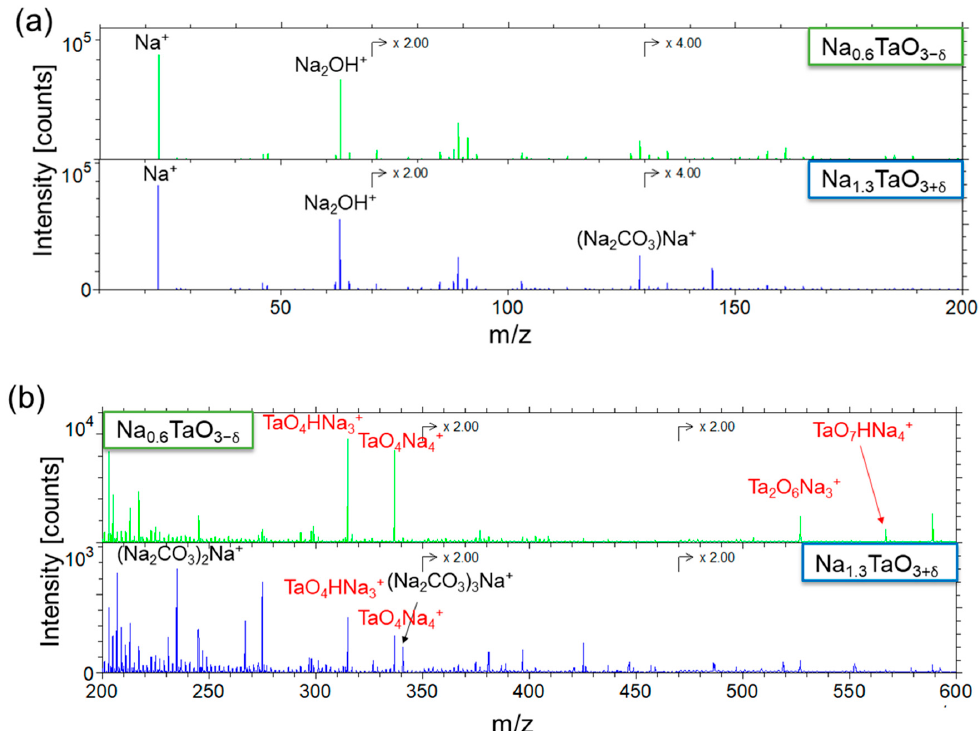
Figure 4. Positive ion ToF-SIMS spectra of Na 0.6 TaO 3- δ and Na 1.3 TaO 3+ δ in the m/z range ( a ) 100–200 and ( b ) 200–600. Both samples were obtained from batch 1_1 (positions 4B and 6C(1), respectively). Only signals ascribed to Na 1+x TaO 3 ± δ and Na 2 CO 3 are reported. The secondary ions characteristic of Na 1+x TaO 3 ± δ are labelled in